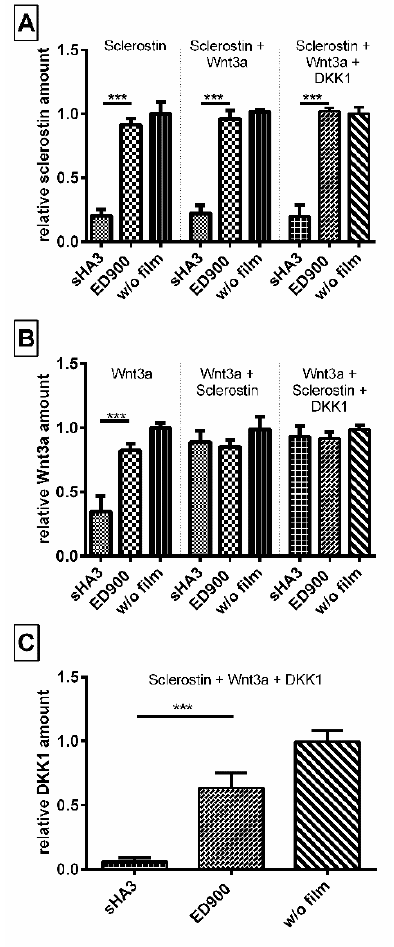
Figure 6. Sclerostin and DKK1 are the preferred binding partner of sHA3 functionalized films. Differently modified films were incubated with the same molar amounts of Sclerostin, Wnt3a, or both proteins combined. Unbound ( A ) Sclerostin, ( B ) Wnt3a, and ( C ) DKK1 was quantified after 24 h from the supernatant via ELISA. Recovery normalized to controls without any films (blank well plates). Film surfaces: ED900: ED900 incubated with soluble sHA3; sHA3: ED900 covalently coated with sHA3. All values represent the mean ± SD of n ≥ 4. *** p < 0.001 denotes significant difference vs. the respective surface modification.